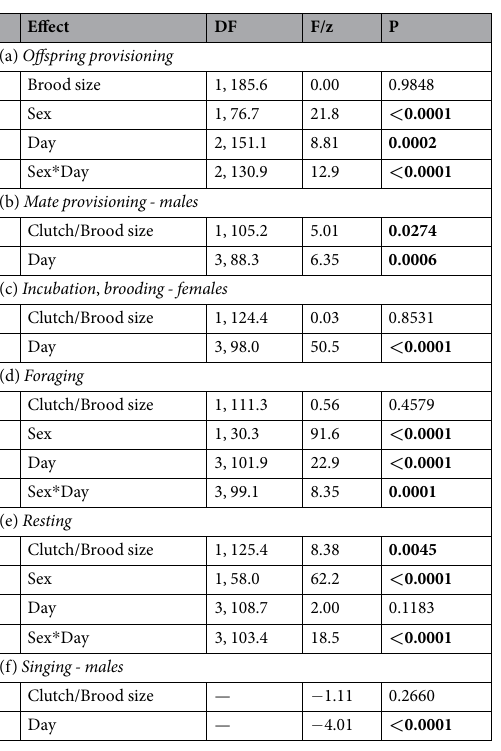
Table 1. Statistical outcome of the six mixed models explaining temporal and sexual variation in behavioural activities. These are full model outcomes, but stepwise removal of the non-significant clutch/brood size effect did not alter any of the significant temporal and sexual effects. Note that mate provisioning, incubation/ brooding and singing are nearly exclusively associated to a particular sex, hence these analyses were restricted to one sex. Analyses (a–e) are general linear mixed models, while analysis (f) is a zero-inflated generalized linear mixed